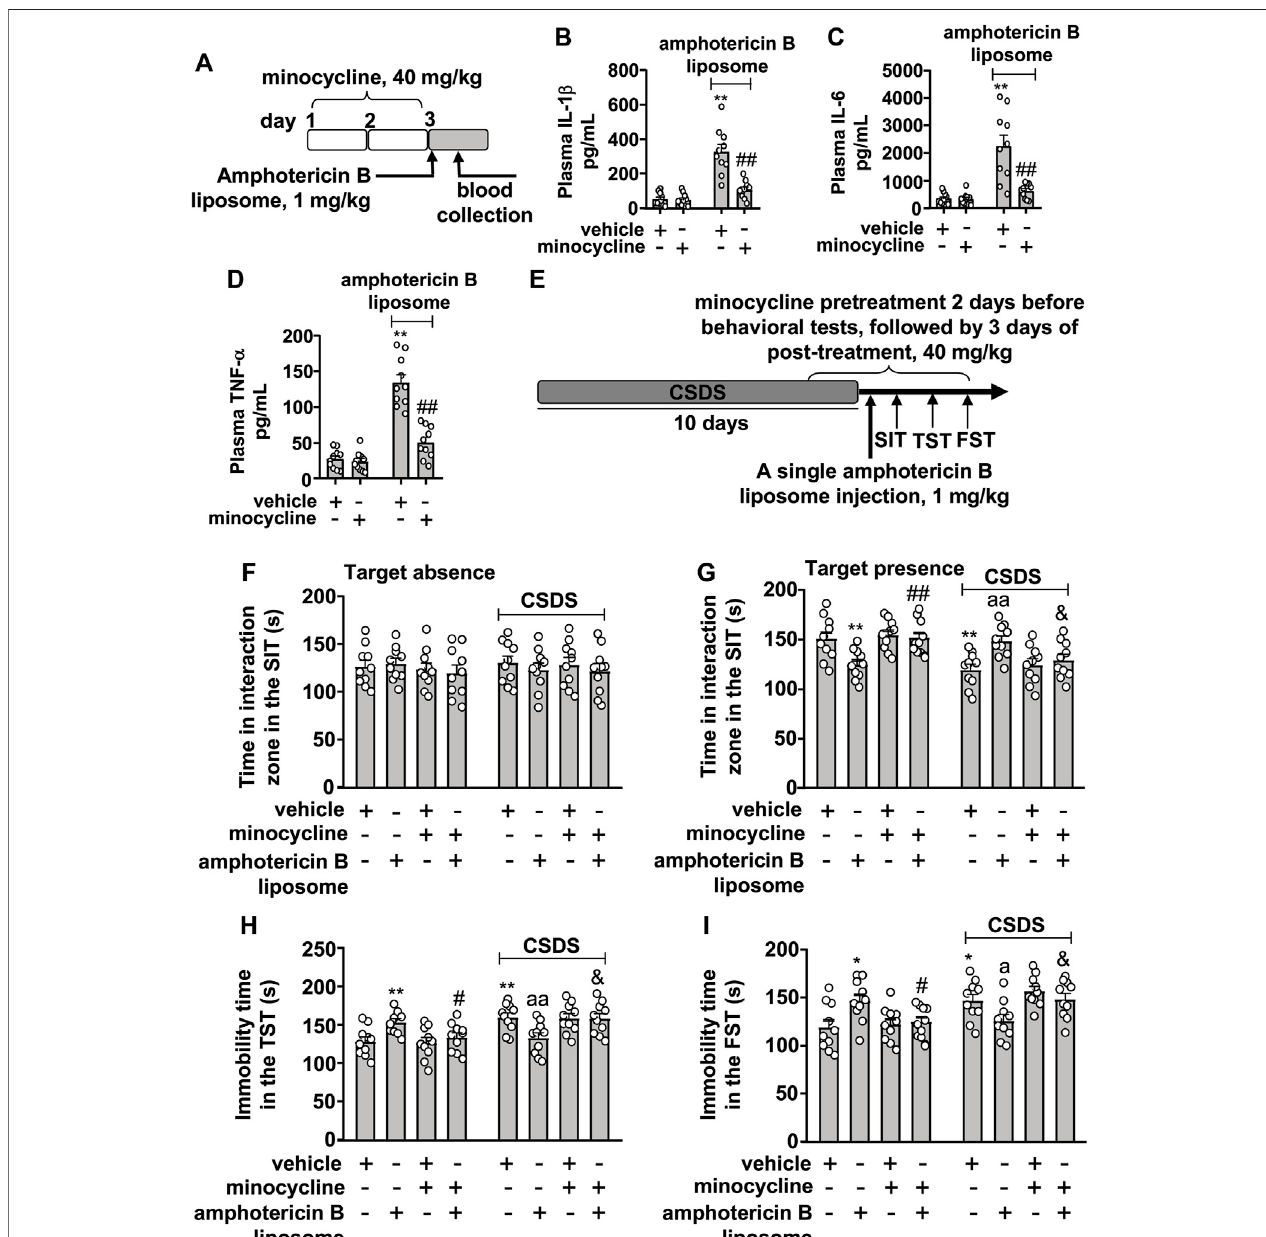
FIGURE 3 | Effect of minocycline pretreatment on amphotericin B liposome-induced reversal of CSDS-induced behavioral abnormalities in mice. (A) schematic diagram shows the experimental setup for minocycline pretreatment and amphotericin B liposome injection in stress-naïve mice. (B – D) Quantitative analysis shows the preventive effect of minocycline pretreatment (40 mg/kg) on the increases in blood IL-1 β (B) , IL-6 (C) , and TNF- α (D) levels induced by injection of amphotericin B liposomes (1 mg/kg) in stress-naïve mice (n = 10, pp p < 0.01 vs. vehicle; ## p < 0.01 vs. vehicle + amphotericin B liposome). (E) A schematic diagram shows the time course of CSDS, SIT, TST, FST, minocycline pretreatment, and/or post-stress amphotericin B liposome injection. (F – I) Quantitative analysis showed that minocycline pretreatment (40 mg/kg) abolished the single amphotericin B liposome injection (1 mg/kg)-induced reversal ofCSDS-induced decrease in the time spent in the interaction zone in the SIT (F,G) and CSDS-induced increases in the immobility time in TST (H) and FST (I) (n = 10, p p < 0.05 or pp p < 0.01 vs. vehicle; ap < 0.05 or aap < 0.01vs.vehicle+CSDS;& p < 0.05vs.amphotericinBliposome+CSDS),andminocyclinepretreatment(40 mg/kg)preventedthesingleamphotericinBliposome injection (1 mg/kg)-induced decrease in the time spent in the interaction zone in the SIT (G) and the amphotericin B liposome-induced increases in the immobility time in TST (H) and FST (I) in stress-naïve mice (n = 10, p p < 0.05 or pp p < 0.01 vs. vehicle; # p < 0.05 or ## p < 0.01 vs. amphotericin B liposome). Data are shown as mean ±